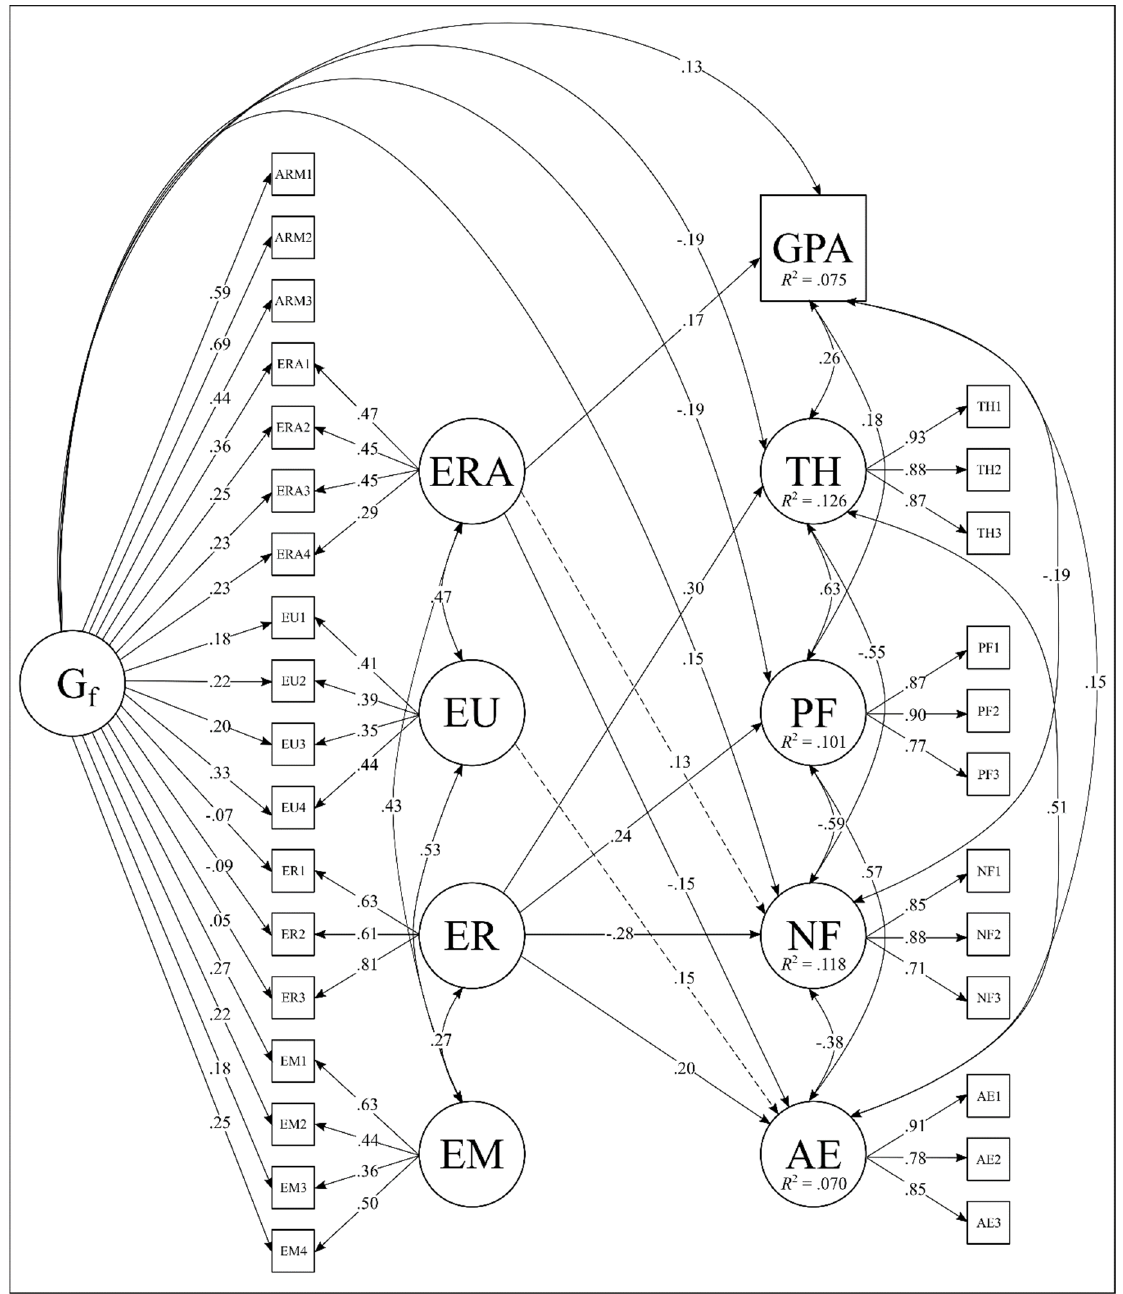
Figure 2. Bifactor (S-1) structural model of associations between latent factors representing general ability (fixed by fluid intelligence), GECo branches, well-being factors, affective engagement and manifest GPA. Parameter estimates are standardized beta coefficients. Statistically significant paths and correlations at p < .05 indicated by solid lines; marginally significant paths at p < .10 indicated by dashed lines. Gf = General ability-fluid intelligence referent; ARM i = Advanced Raven’s Matrices; ERA i = Emotion Recognition Ability; EU i = Emotion Understanding; ER i = Emotion Regulation; EM i = Emotion Management; TH i = Thriving; PF i = Positive Feeling; NF i = Negative Feeling; AE i = Affective Engagement. i : parcel indicator.